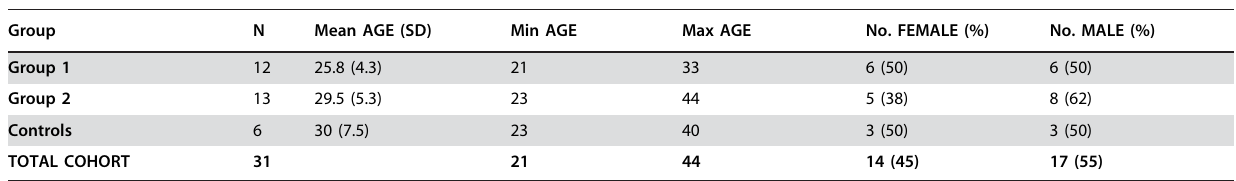
VACCINE DOSE 1 Group 1, n=12 Group 2, n=13 n % n % Documented Fever . 37.5 Symptoms of feverish